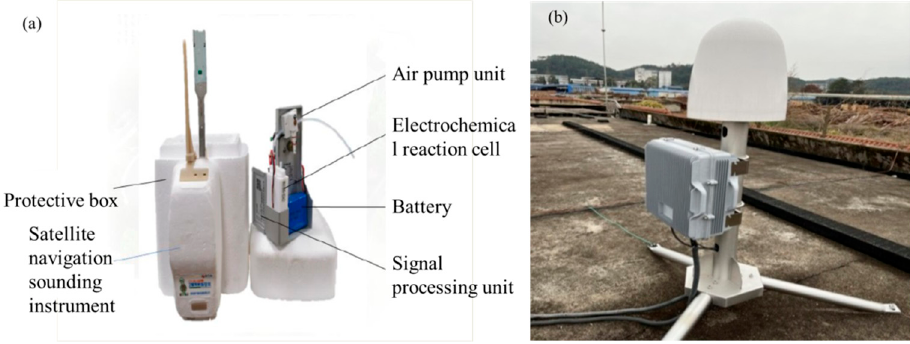
Figure 2. Major sounding instruments : ( a ) CTY-1 ozone sounding sensor and ( b ) Beidou Satellite navigator.